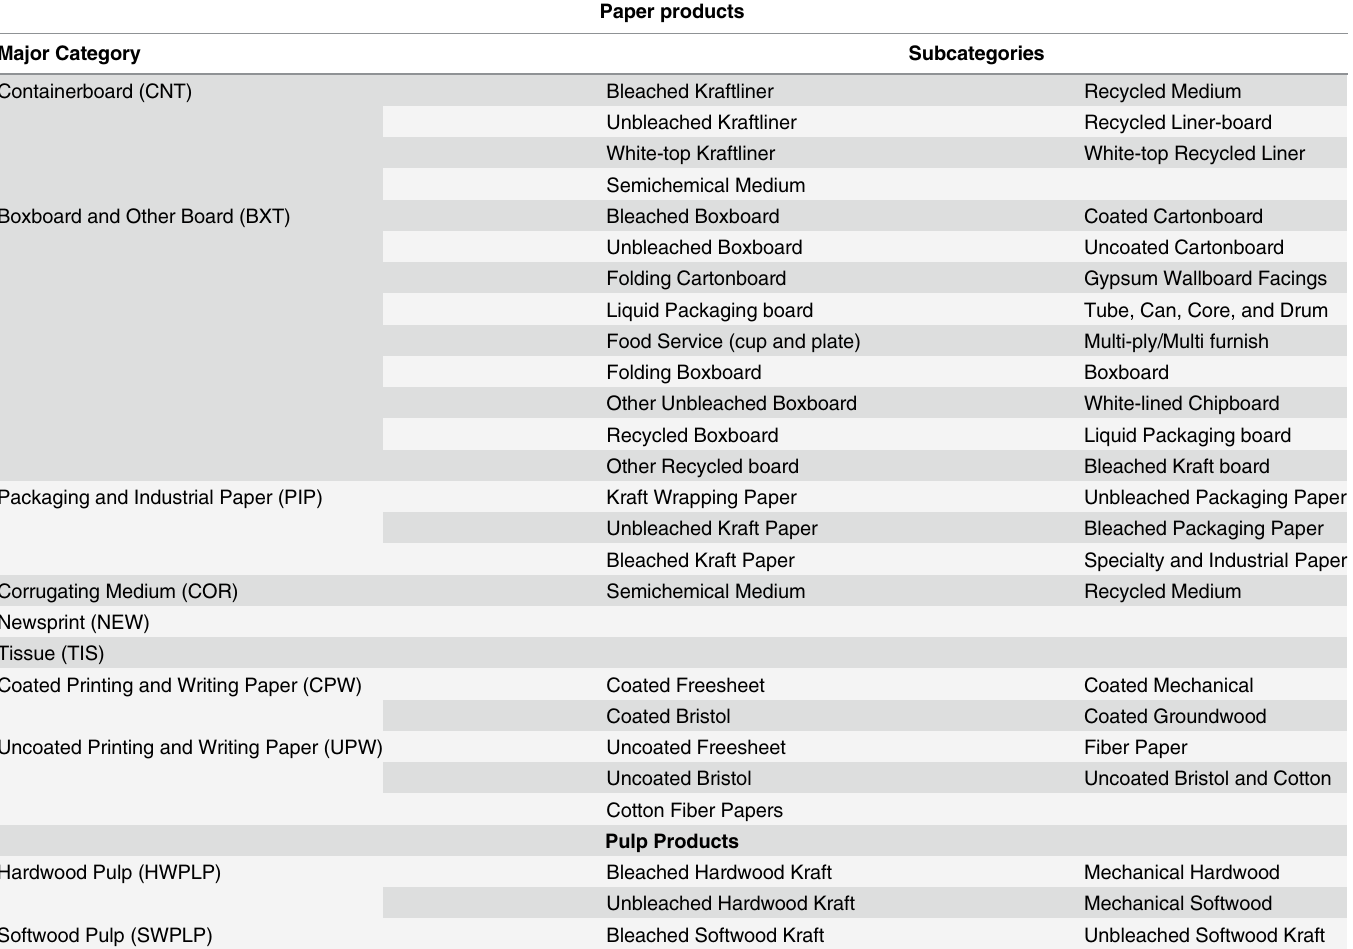
Table 1. ISIS product categories for the U.S. pulp and paper